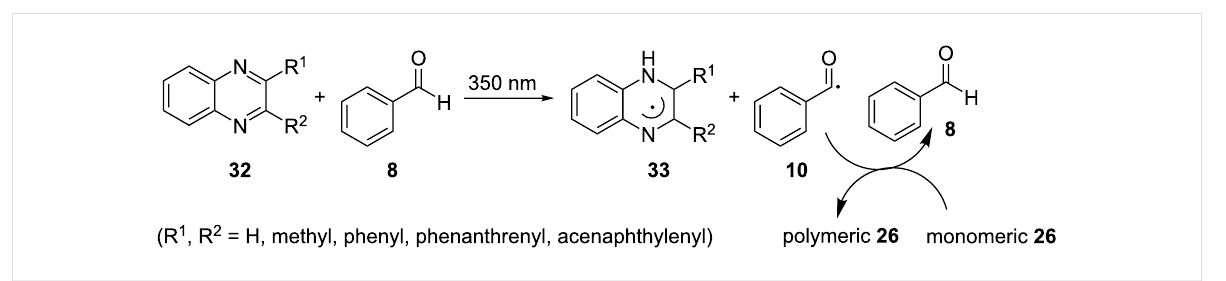
Scheme 9: Photoinitiated polymerization of monomeric MMA ( 26 ) using the quinoxalines 32 and benzaldehyde ( 8